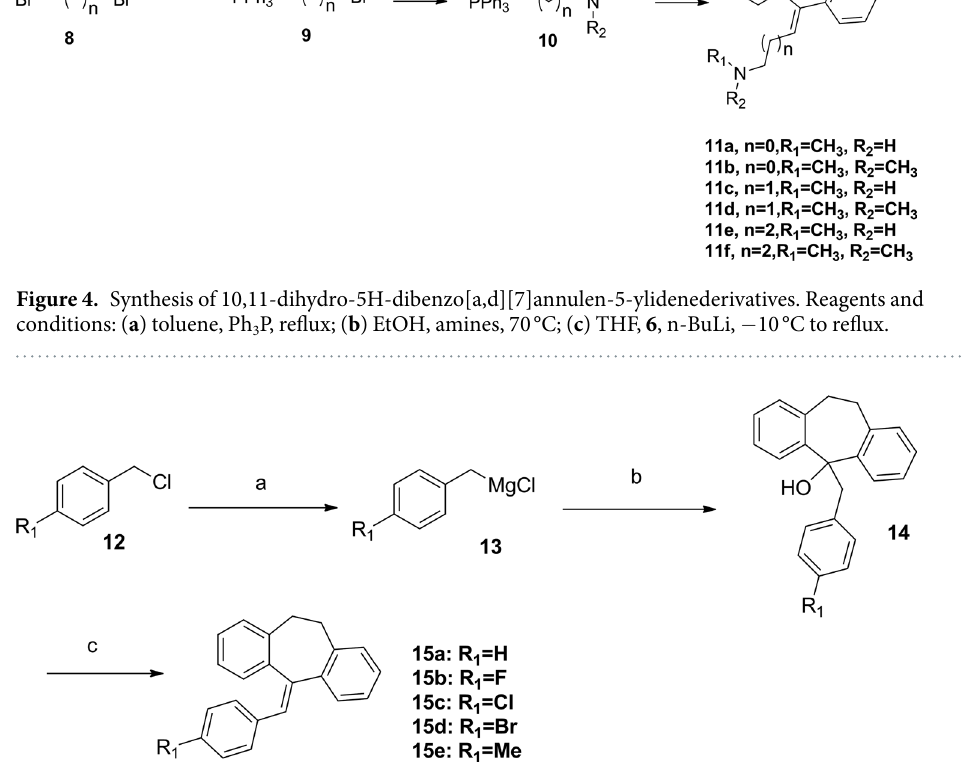
Figure 5. Synthesis of 10,11-dihydro-5H-dibenzo[a,d][7]annulenederivatives. Reagents and conditions: ( a ) THF, Mg, I 2 ; ( b ) THF, 6 ; ( c )